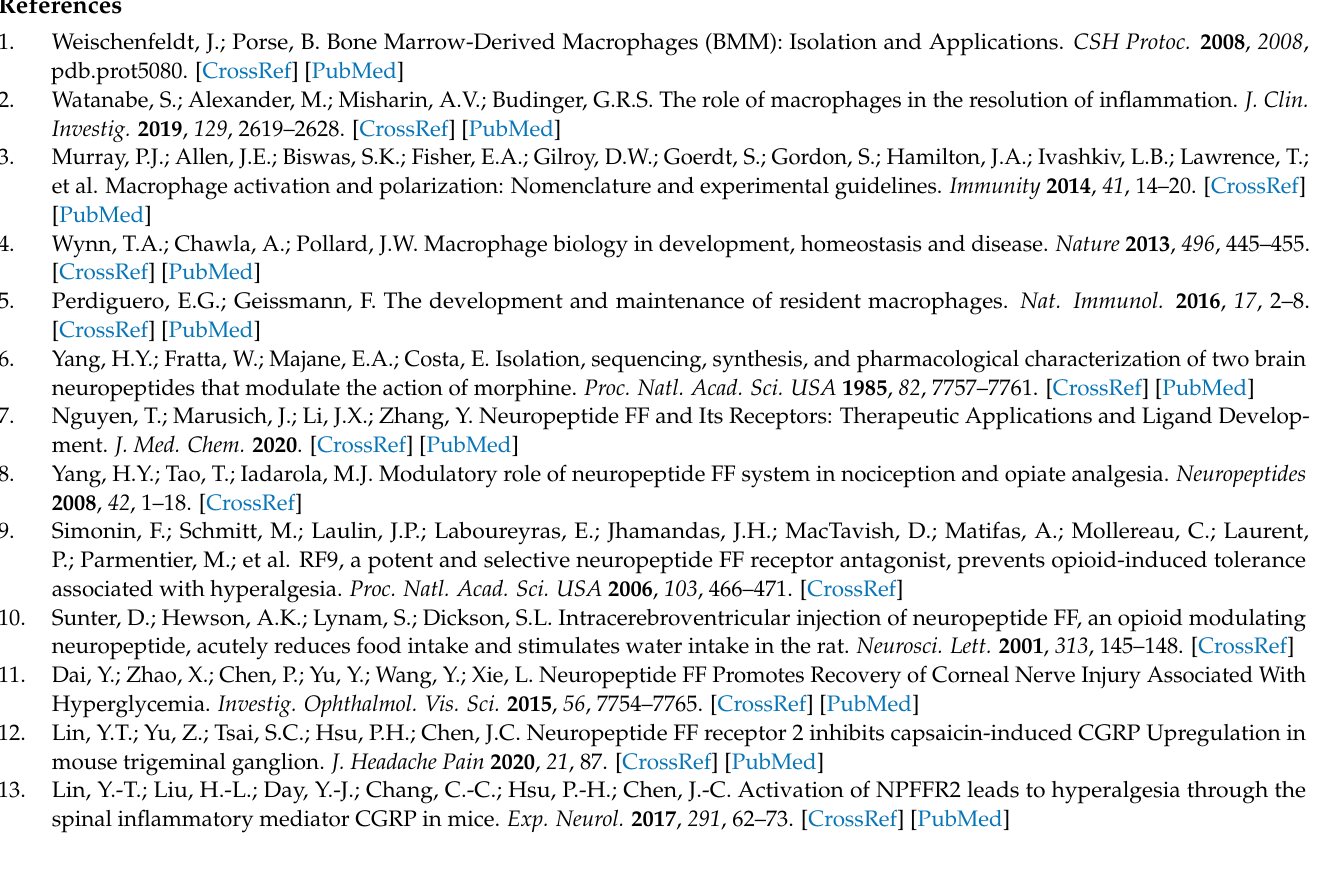
Table S6: KEGG pathway; Table S7: GO analysis of hub genes; Table S8: transcriptor factors-up DEGs; Table S9: transcriptor factors-down DEGs; Table S10: Proteins modelling; Table S11: Ramachandran plot analysis; Table